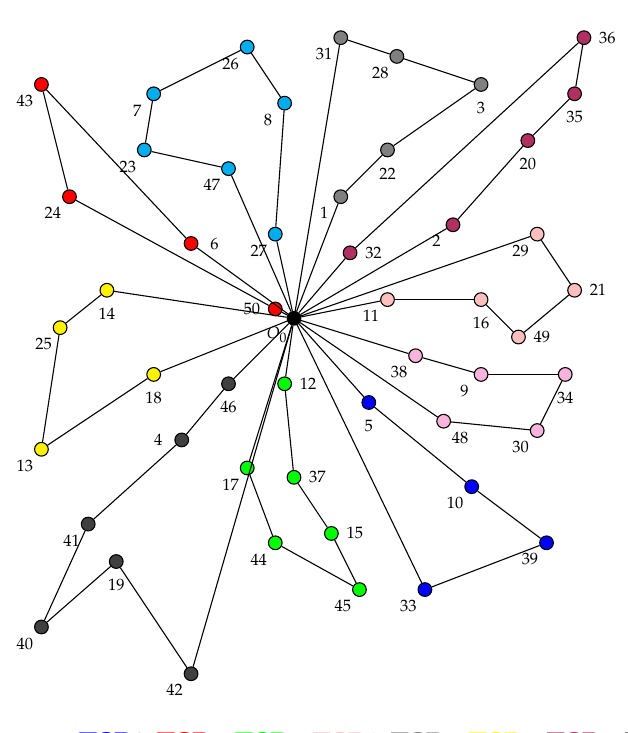
Figure 7. Tour for